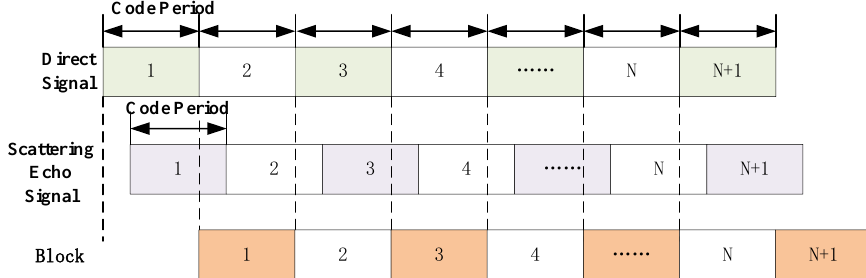
Figure 5. Schematic diagram of block operation.